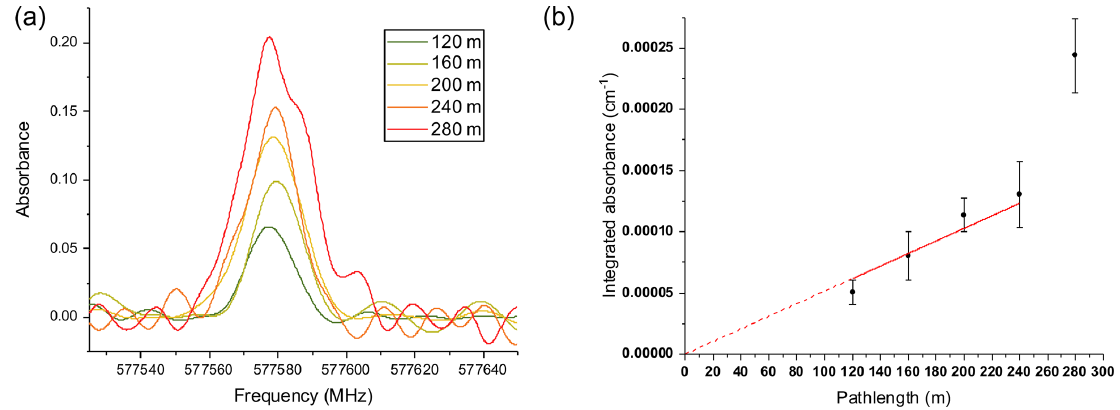
Figure 5. (a) Absorbance of the R( 22 ) rotational line of N 2 O in its ground state measured with the AMC THz source in the 577.58GHz region for 6 different path lengths in MULTICHARME ( χ air = 400ppmv, P = 4mbar). (b) Linear fit of the of path length dependence of the integrated absorbances instrumentally weighted on the error bars deduced from the Lorentzian fits of the absorbances shown in (a)